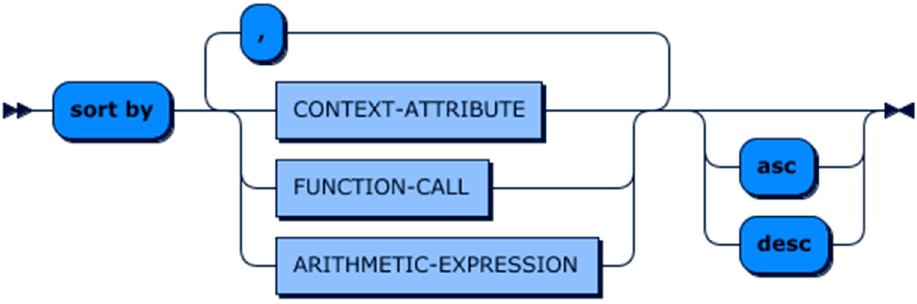
Figure 12. SORT-BY clause production rule.